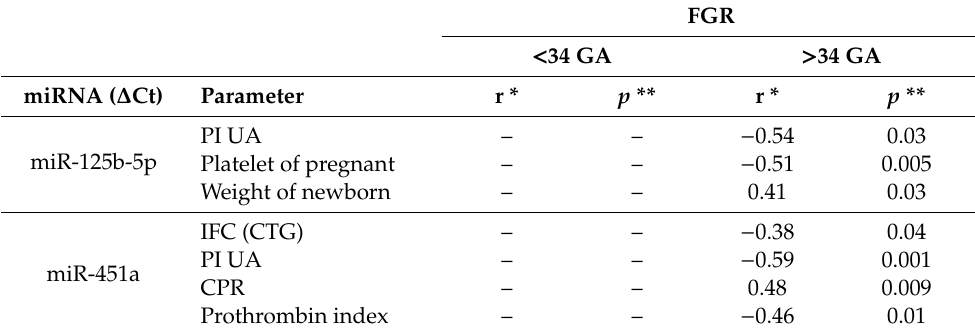
Table 3. The results of a correlation of miRNA expression level in cord blood with Doppler measurement, laboratory indicators of pregnant women and clinical state assessments of newborns with FGR.